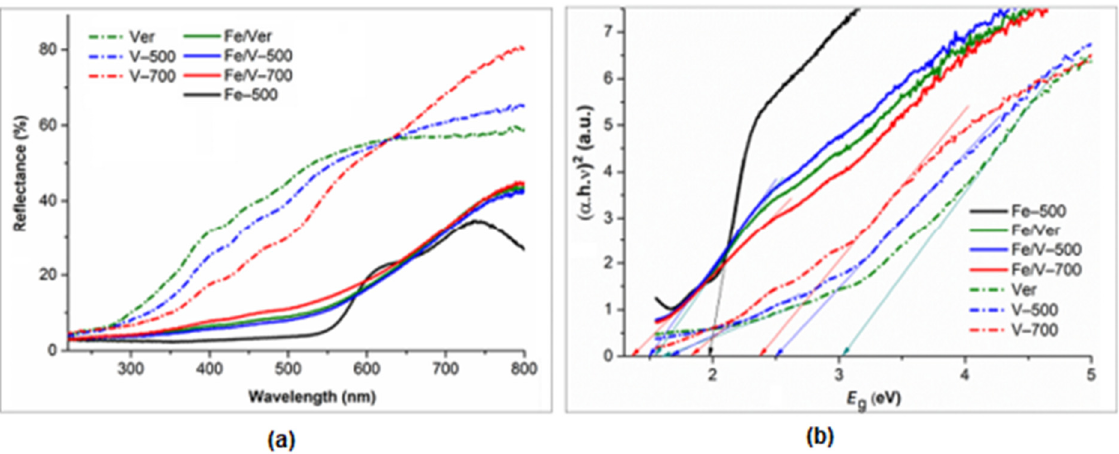
Figure 5. DRS spectra ( a ) and Tauc plots ( b ) of vermiculites, α -Fe 2 O 3 nanoparticles and α -Fe 2 O 3 /ver- miculite composites. /vermiculite composites.